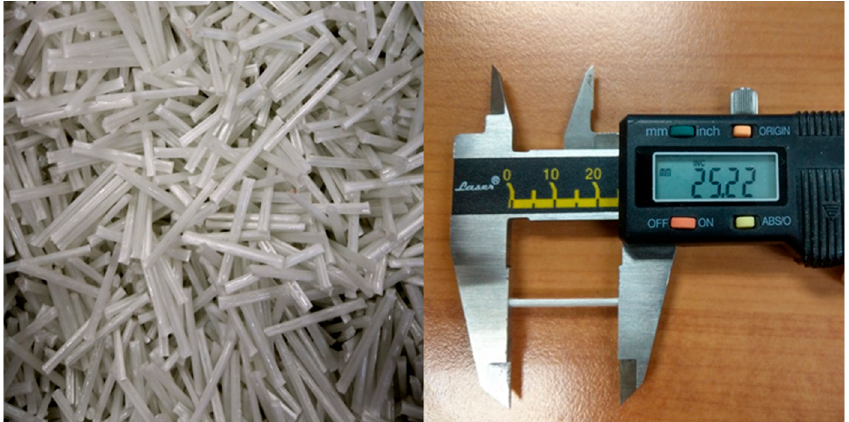
Figure 1. Long-glass-fiber